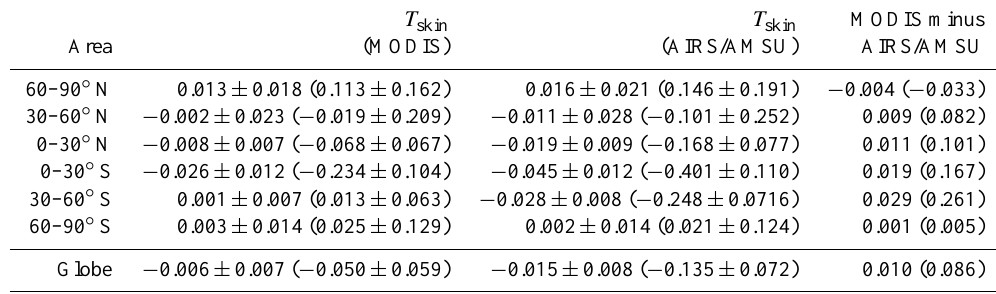
Table 3. The rate of the surface skin temperature change (Kyr − 1 ) of MODIS and AIRS/AMSU over the nine global areas during the period from September 2002 to August 2011. The ± values define the 95% confidence intervals for the trends. The values in parentheses indicate the rates of temperature change (K9yr − 1 ) for the whole period. Note that the rates are subject to large uncertainty due to the short periods of the satellite-based temperature records.